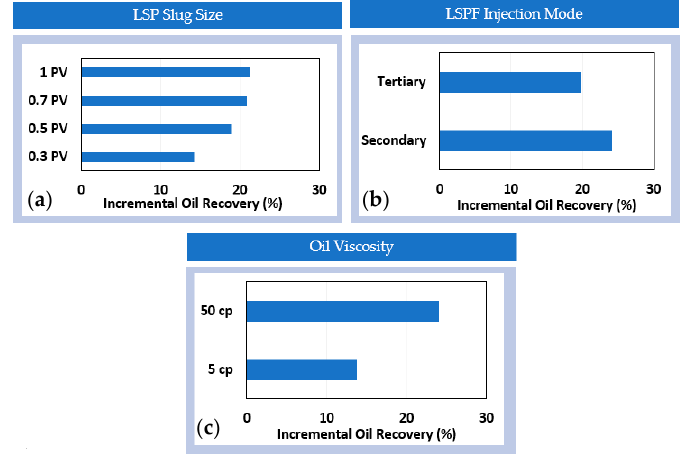
Figure 21. Effect of ( a ) slug size; ( b ) injection mode; and ( c ) oil viscosity, on the performance of LSPF in terms of incremental oil recovery [129].